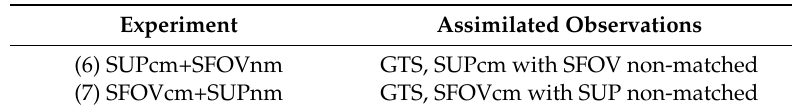
Table 2. The configuration of numerical experiments for optimal evaluation of the IR and MW soundings. The designed experiments are abbreviated in the left column, and assimilated observations are listed in the right